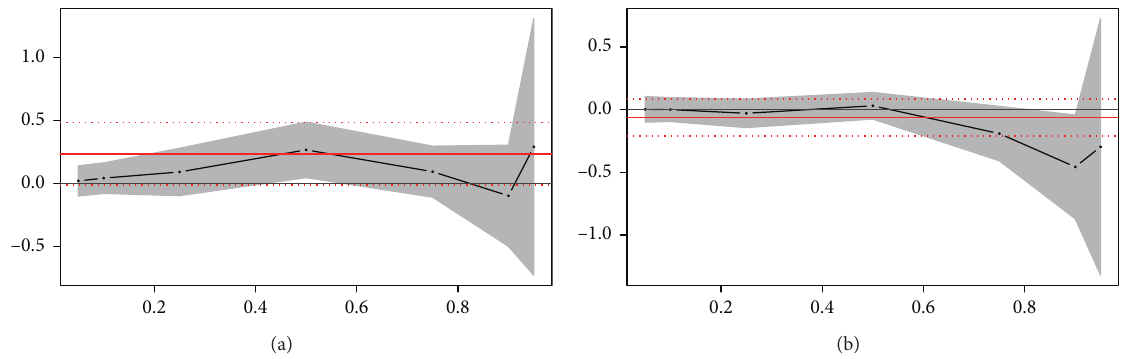
Figure 4: Estimation formula (16) of regression coefficients at different loci. (a) Under different loci 􏽢 λ optimistic and pessimistic sentiment changes will cause the stock market to fluctuate up and down. While the stock market volatility itself is large （ τ ≥ 0 . 90 ） 􏽢 λ